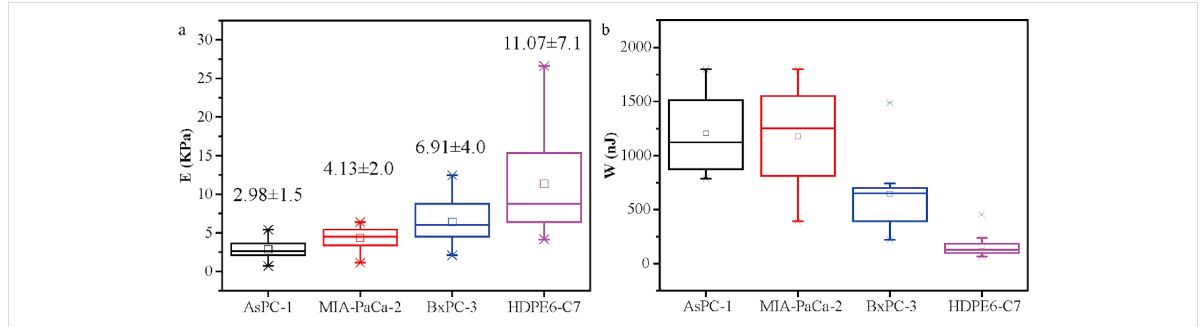
Figure 4: Statistics of (a) Young's modulus and (b) energy dissipation for AsPC-1, MIA-PaCa-2, BxPC-3, and HDPE6-C7.